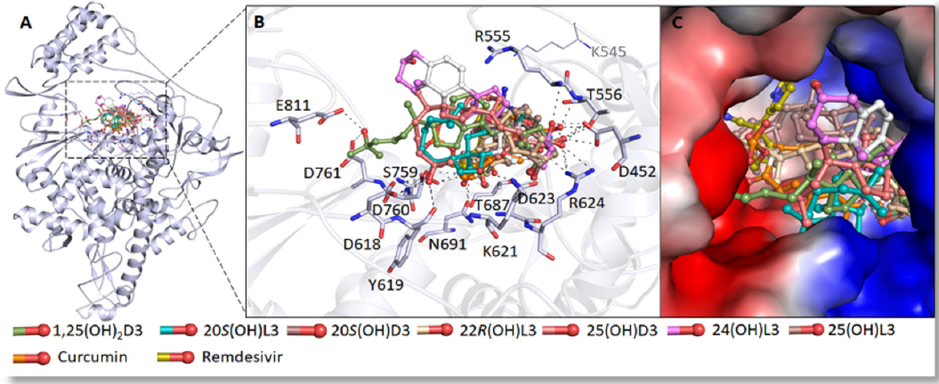
Figure 4. The binding pattern of identified sterols and secosteroids with SARS-CoV-2 RdRp. ( A ) structural representation of the protein in complex with selected compounds. ( B ) active site residues of the RdRp-binding pocket making significant interactions with each of the identified compounds. ( C ) surface view of the RdRp active site with the electrostatic potential from red (negative) to blue (positive) in complex with selected compounds. RdRp, RNAdependent RNA polymerase. Reprinted with permission from the publisher [74].